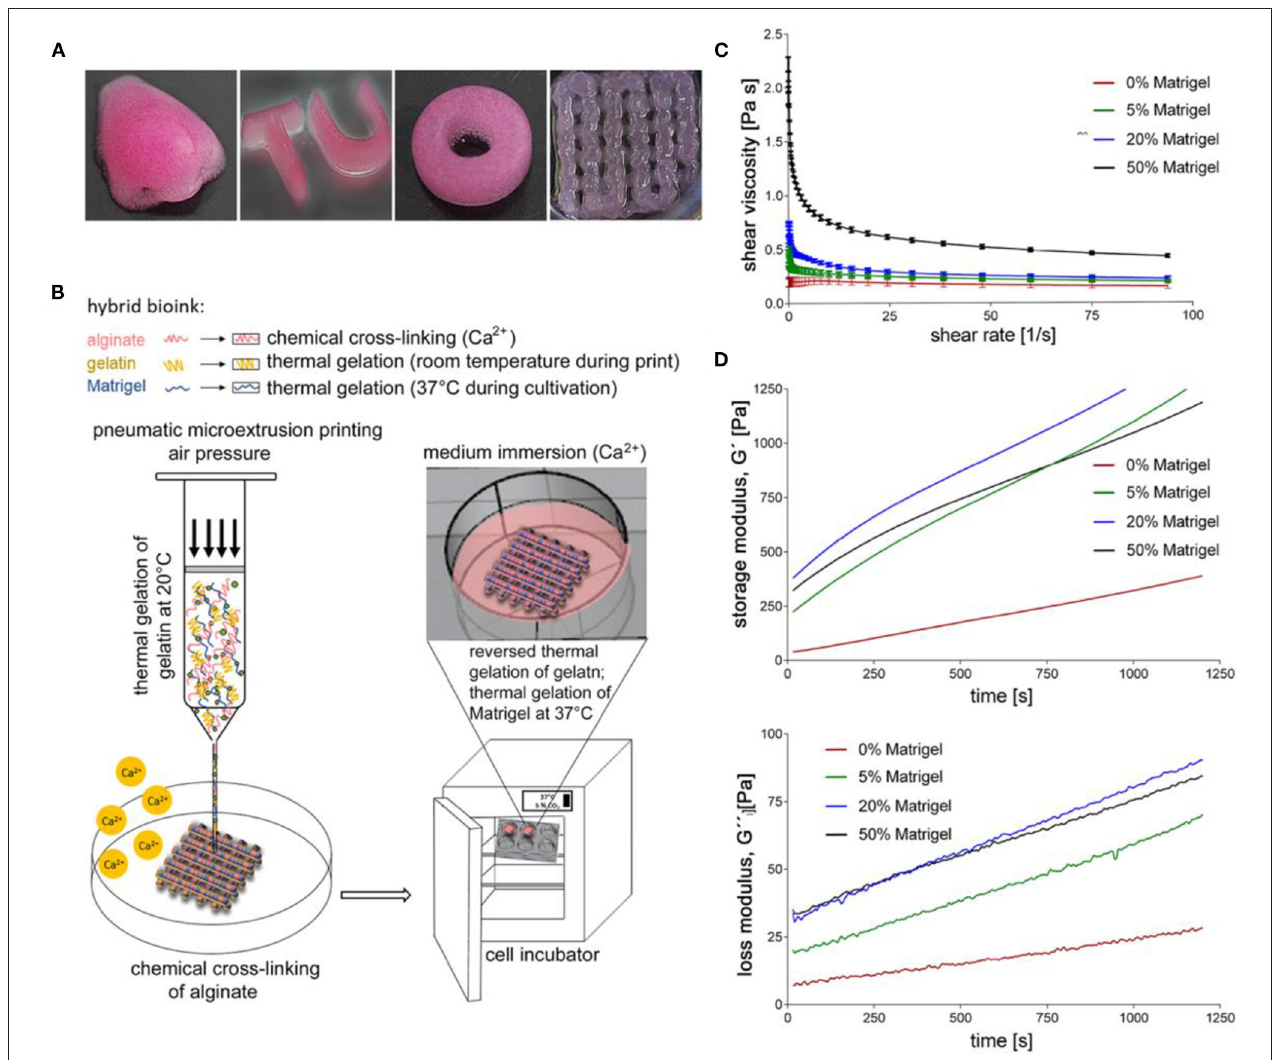
FIGURE 6 | 3D printed cultures of A549 cells. (A) Various shapes of constructs made through extrusion printing. (B) Illustration of 3D printing setup. (C) Viscosity of uncrosslinked bioinks at a shear rate sweep of 1–100 s − 1 at 24 ◦ C. (D) Storage and loss modulus of bioink formulas at 1Hz, 24 ◦ C, and 1% shear strain after the addition of CaSO 4 . This figure is reprinted under the terms of the Creative Commons Attribution License from Berg et al.